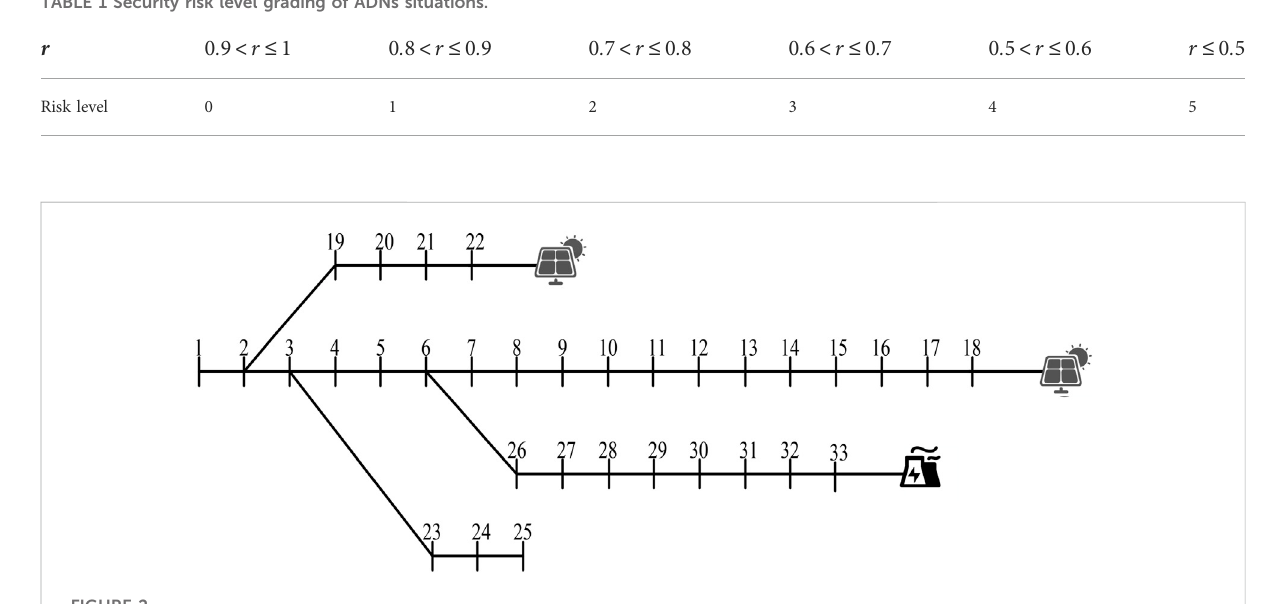
FIGURE 2 An ADN based on IEEE 33-node standard distribution system.